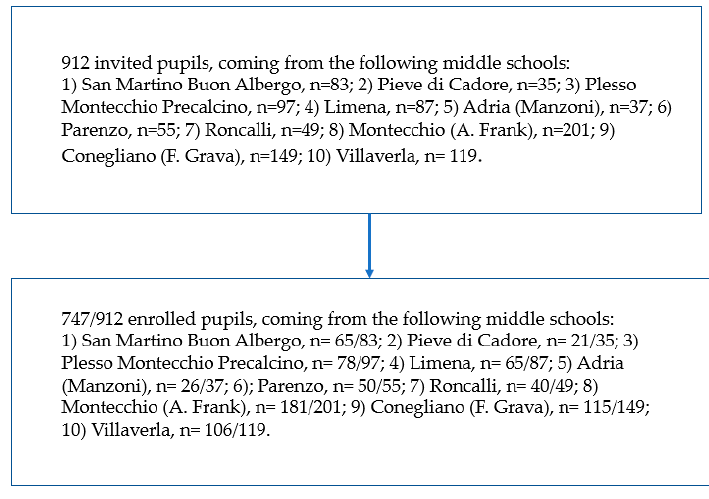
Figure 1. Flow-chart representing enrollment model.